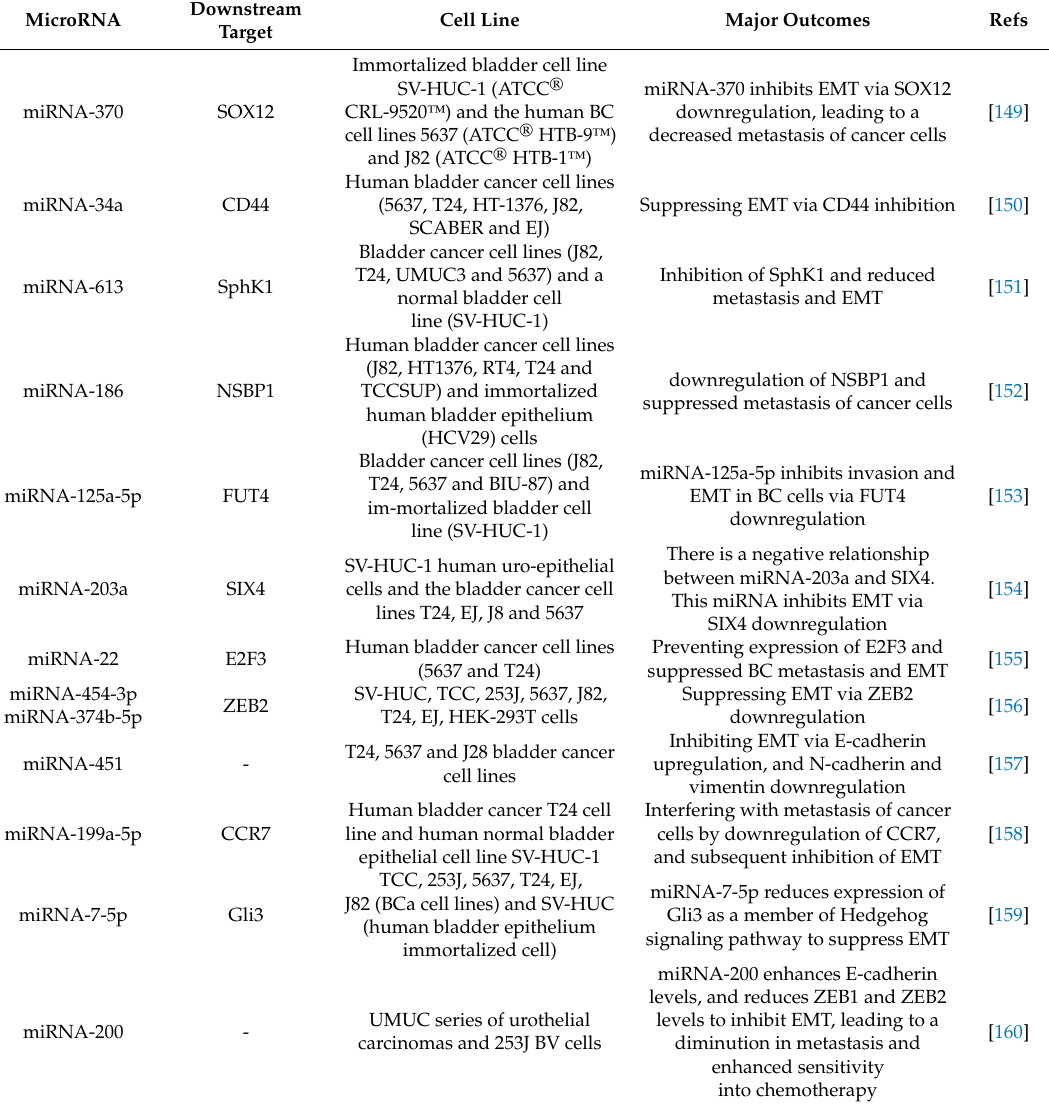
Table 1. MicroRNAs inhibit EMT in BC